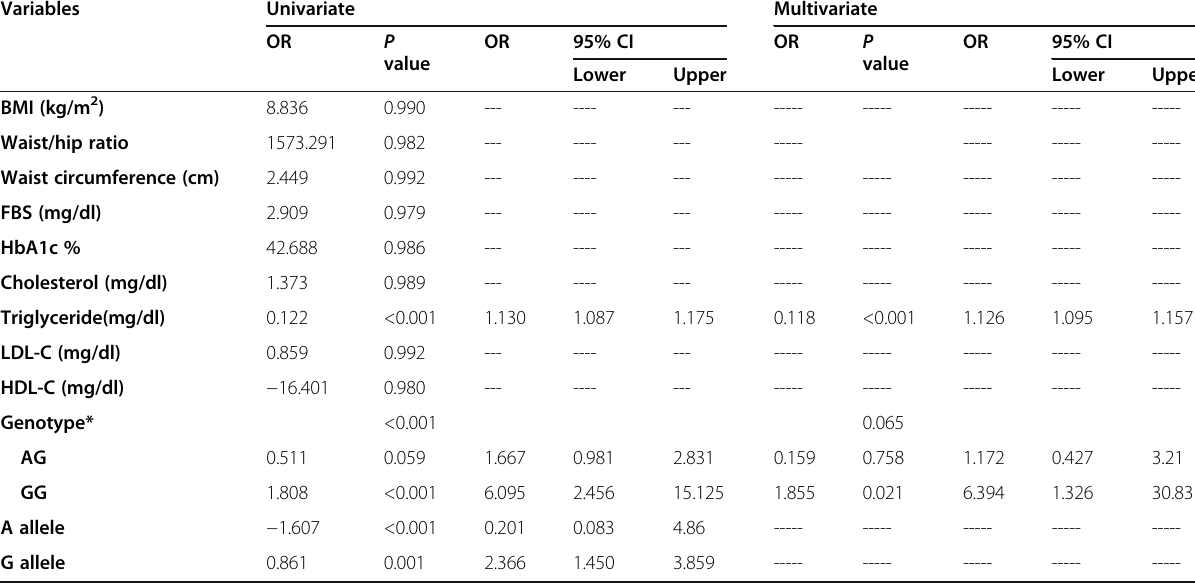
Table 5 Univariate and multivariate logistic regression among patients and controls Variables